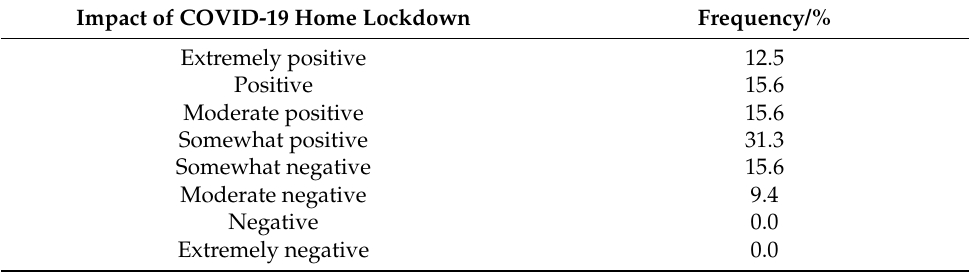
Table 4. Impact of the COVID-19 home lockdown on athletes’ lives. Impact of COVID-19 Home